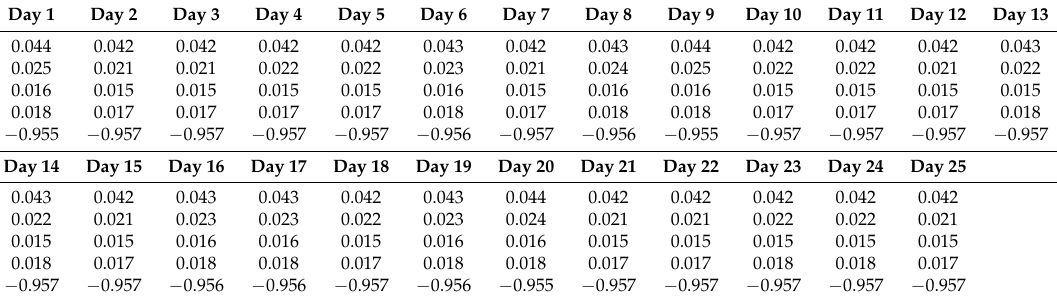
Table 4. Normalized R N matrix.